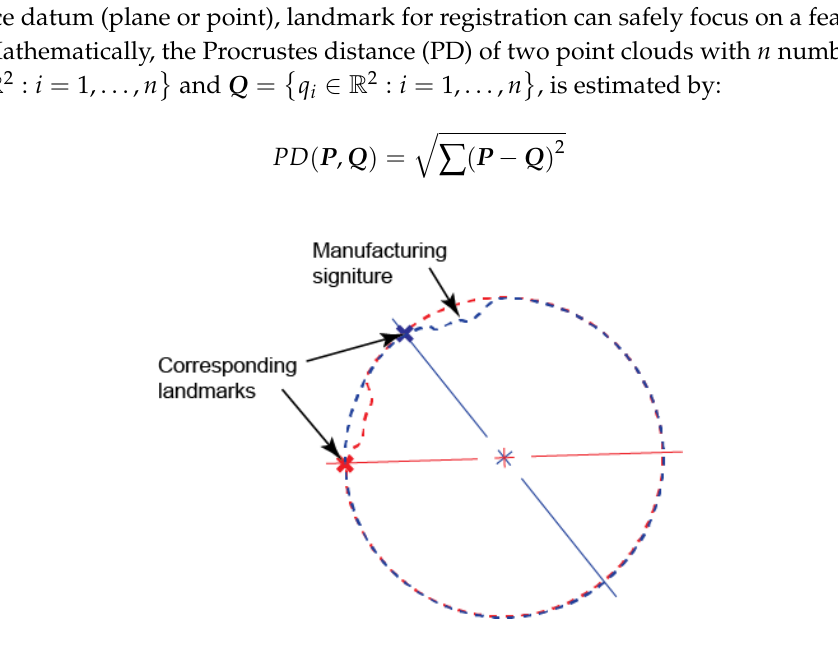
Figure 2. A top-view of two unregistered superimposed cylinders.